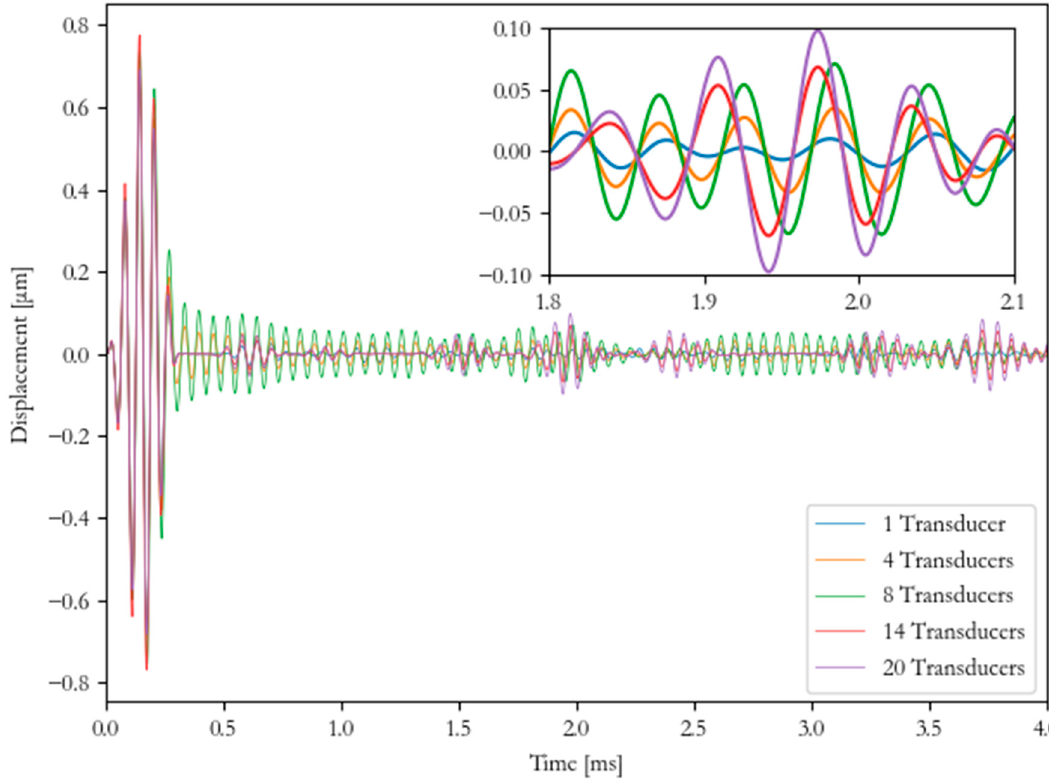
Figure 8. Numerical results of di ff erent numbers of transducers excited at 16 kHz in time-domain.